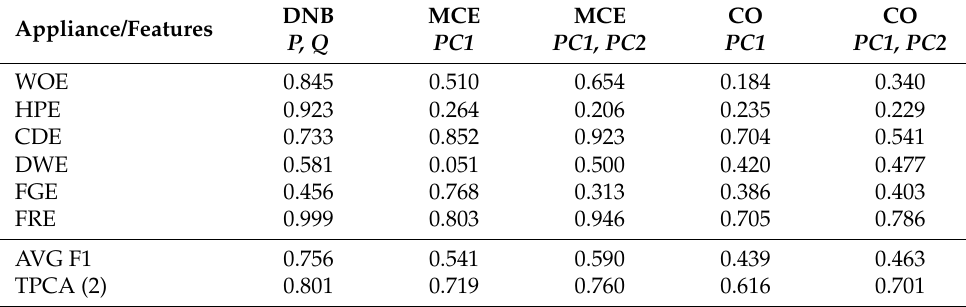
Table 7. Comparison to MCE and CO Methods with PCA